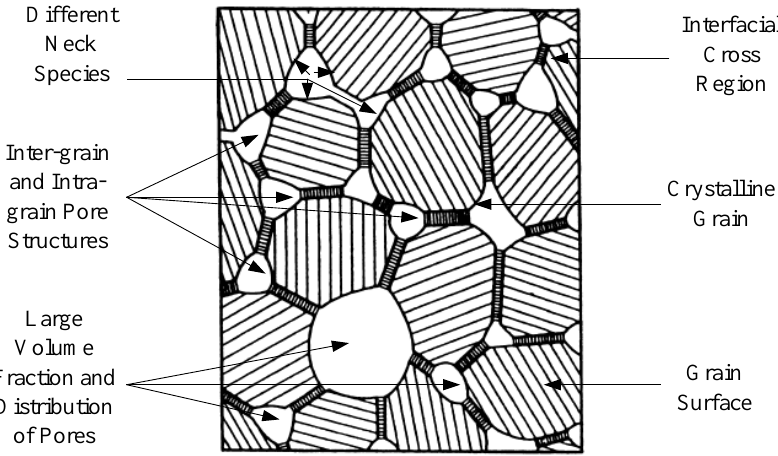
Figure 6. Layout of nanocrystalline ceramic with the different superficial